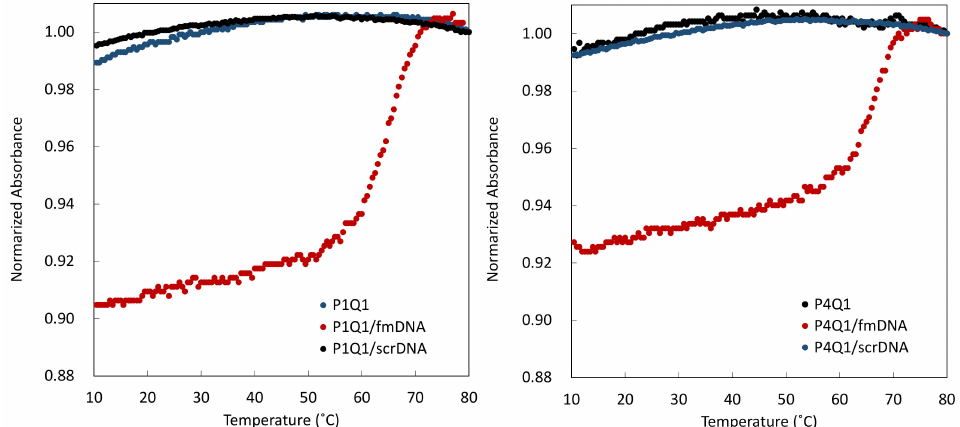
Figure 2. Temperature dependences of absorption intensity at 260 nm for: ( left ) 1:1 mixtures of P1Q1 /fmDNA (red-filled circles) and P1Q1 /scrDNA (black-filled circles), and P1Q1 alone (blue- filled circles); and ( right ) 1:1 mixtures of P4Q1 /fmDNA (red-filled circles) and P4Q1 /scrDNA (black-filled circles), and P4Q1 alone (blue-filled circles).